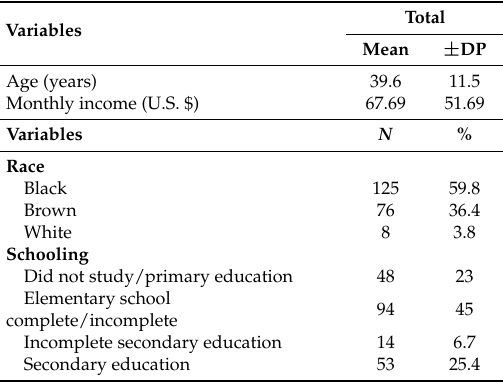
Table 2. Socio-demographic characteristics of shellfish gatherers sample ( N = 209) from Saubara, Bahia-Brazil.